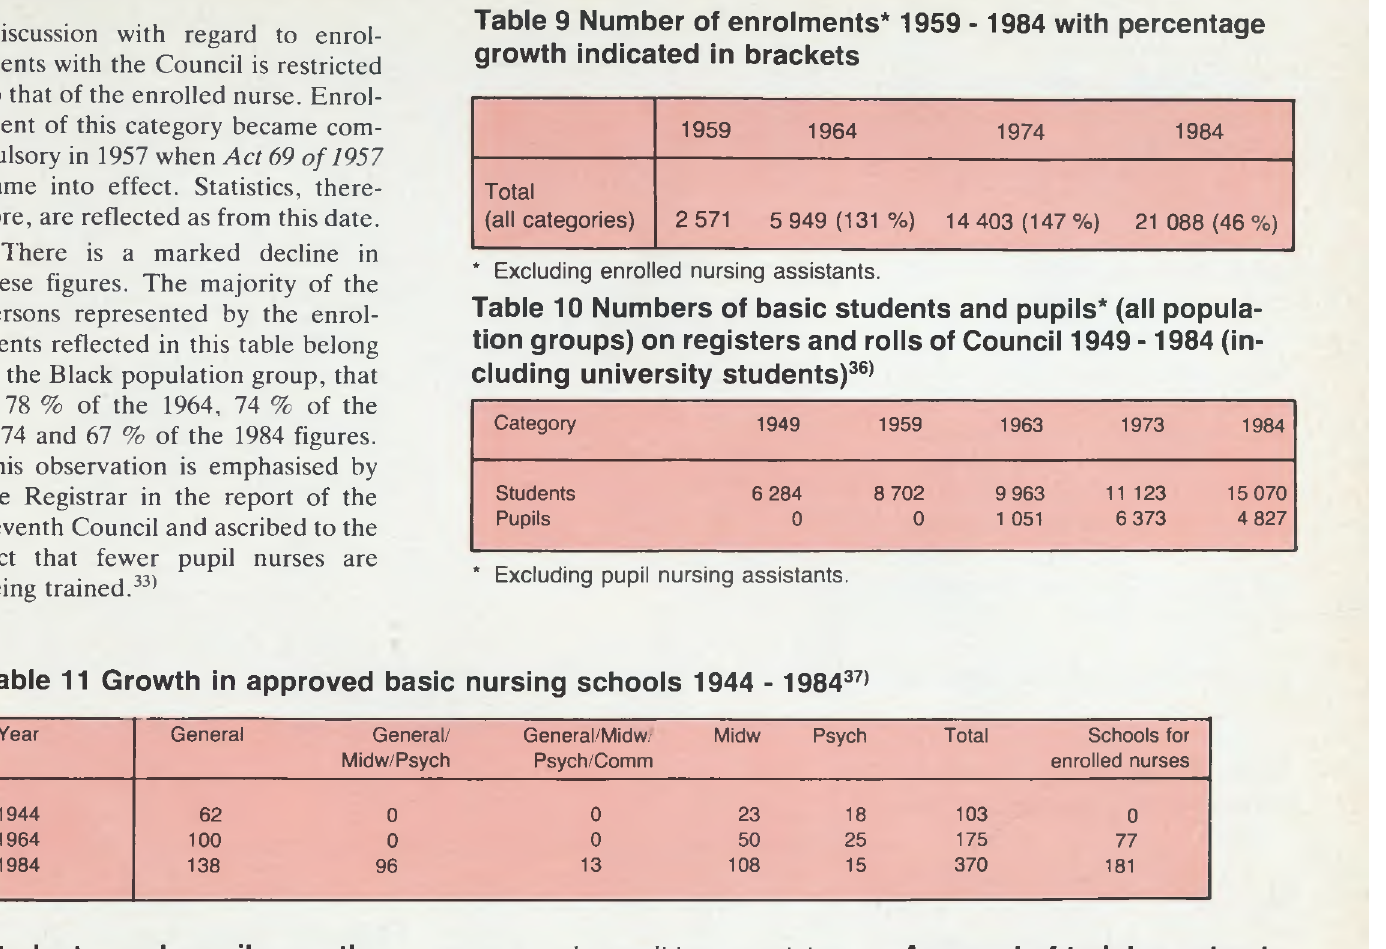
Table 11 Growth in approved basic nursing schools 1944 -